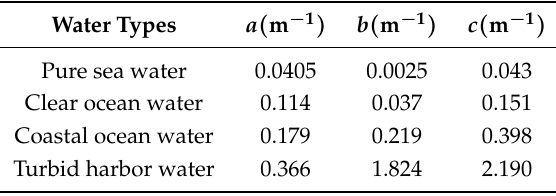
Table 1. Coefficient values of typical water types at 520